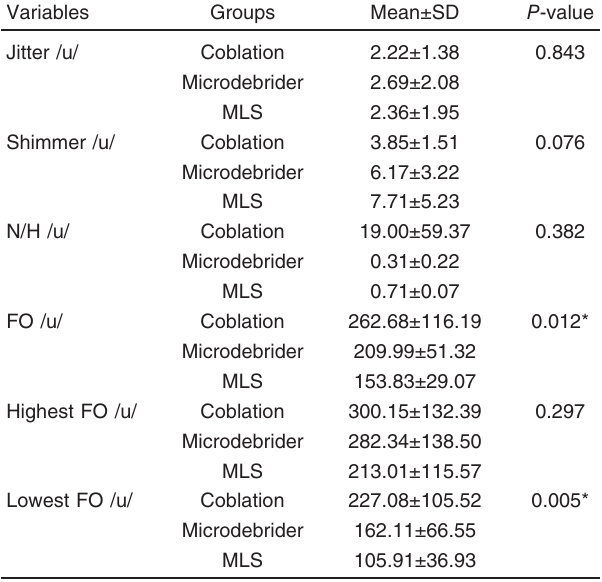
Table 5 Comparison between the three groups regarding baseline data of computerized speech lab. /u/ (preoperatively)